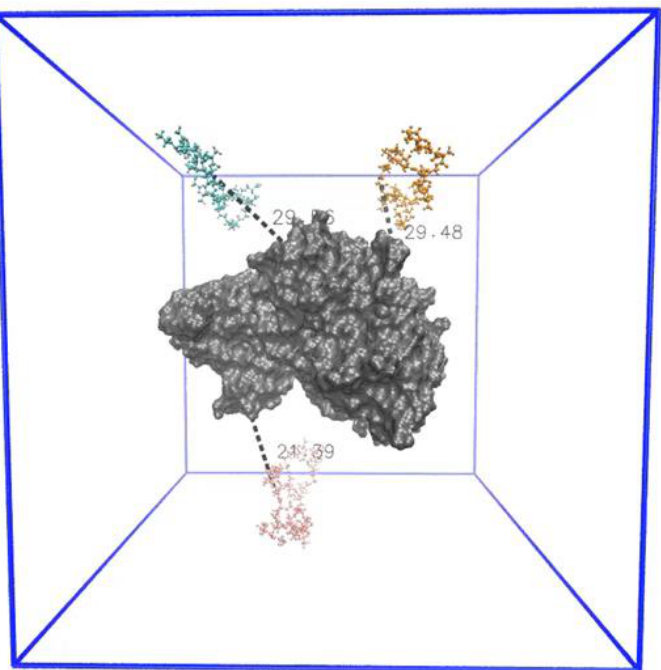
Figure A1. An example of an initial configuration of a polymer/ID2S simulation box, whereby oligomers are ~2–3 nm away from the protein surface. Different simulation trials were generated using PACKMOL by placing polymer oligomers in different areas within the simulation box, while maintaining a 3 nm distance.